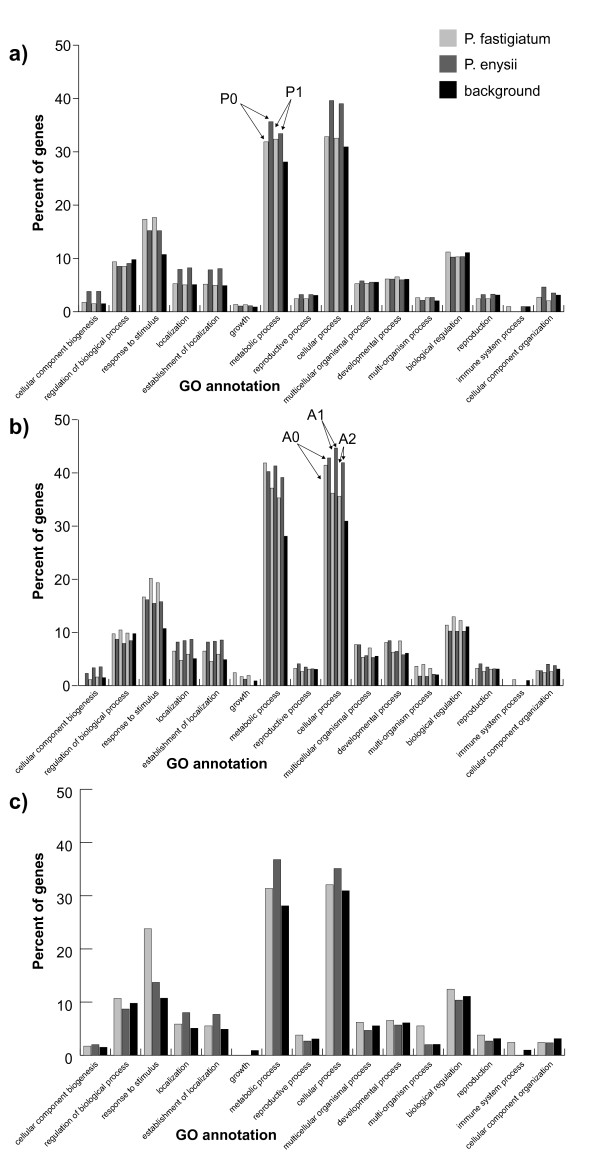
AgriGO analyses of differentially expressed genes obtained with reference sets P0 and P1 (a), A0, A1 and A2 (b) and microarrays (c). With microarrays, category ‘response to stimulus’ was enriched in P. fastigiatum and categories ‘cellular process’, ‘metabolic process’, ‘localization’ and ‘establishment of localization’ were enriched in P. enysii (c). The same categories were enriched with tag profiling when using the P. fastigiatum reference ESTs with category ‘response to stimulus’ also enriched in P. enysii (a). Also, similar enrichment patterns were found when using A. thaliana ESTs as a reference, except for the differences between species being not as clear for some categories when mapping with no mismatch (A0).